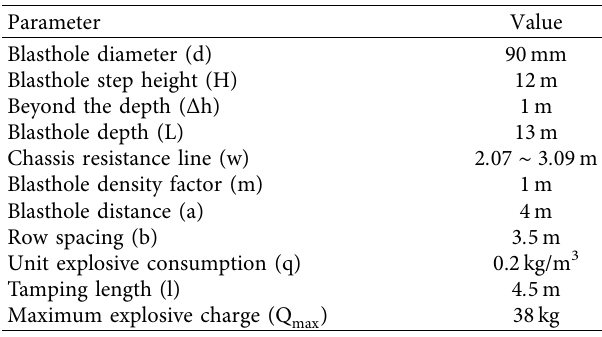
Figure 4: The layout of the blasthole depth.